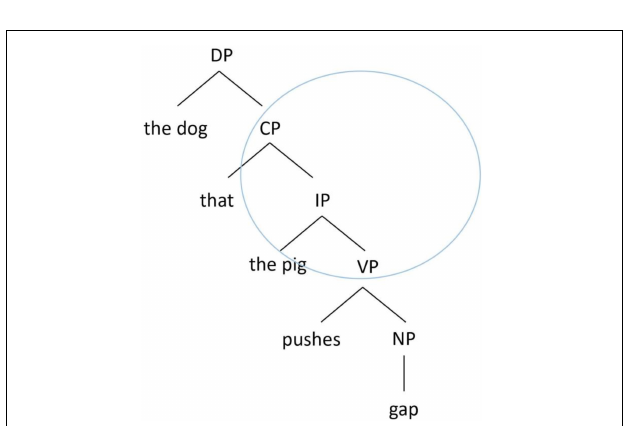
FIGURE 1 | Hierarchical structure of an English subject RC.